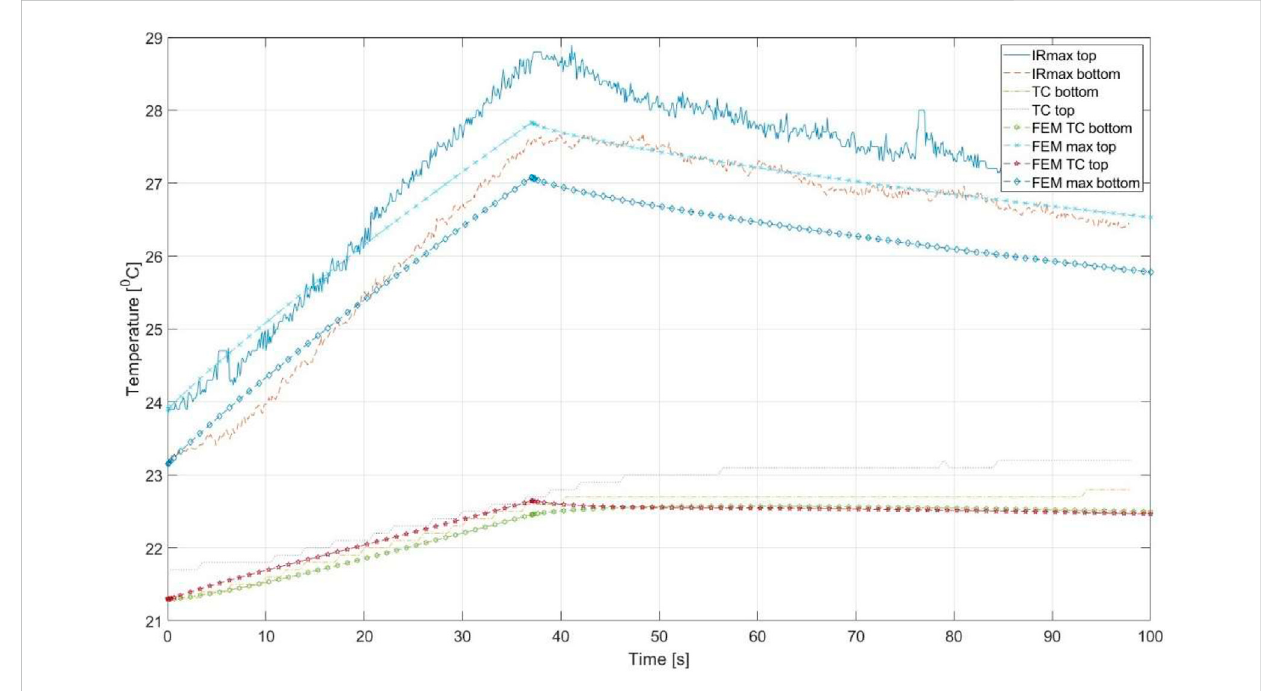
FIGURE 20 Recorded and computed temperatures for the UD [0] 36 plate